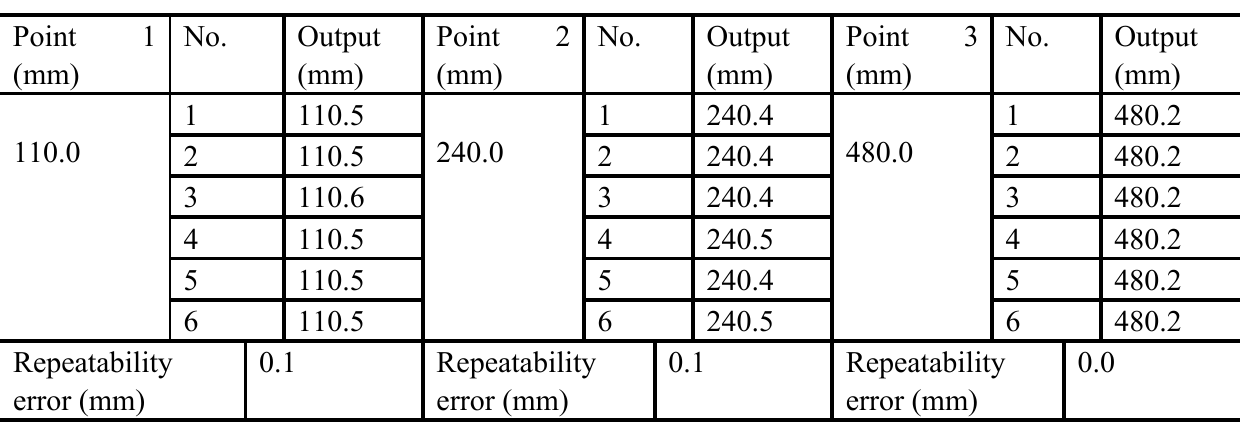
Table 3. Repeatability experiment